Question: Reading the figure, is the described quantity rising or falling?
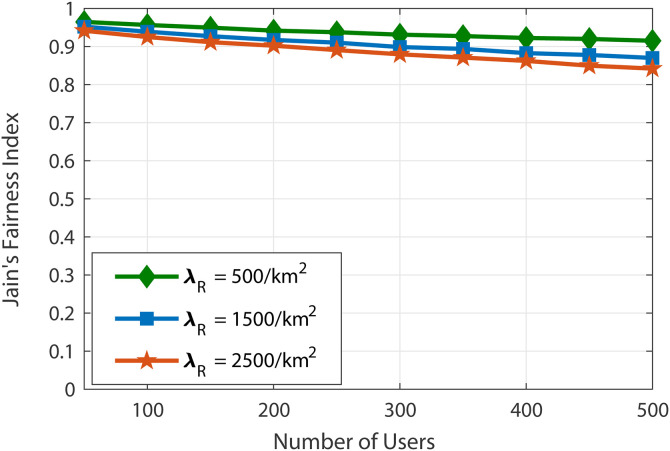
Answer: increasing